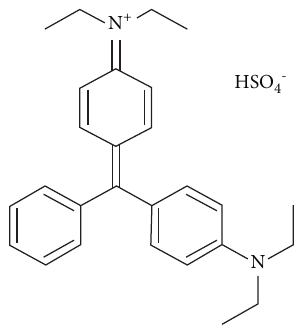
Figure 1: Structure of brilliant green dye